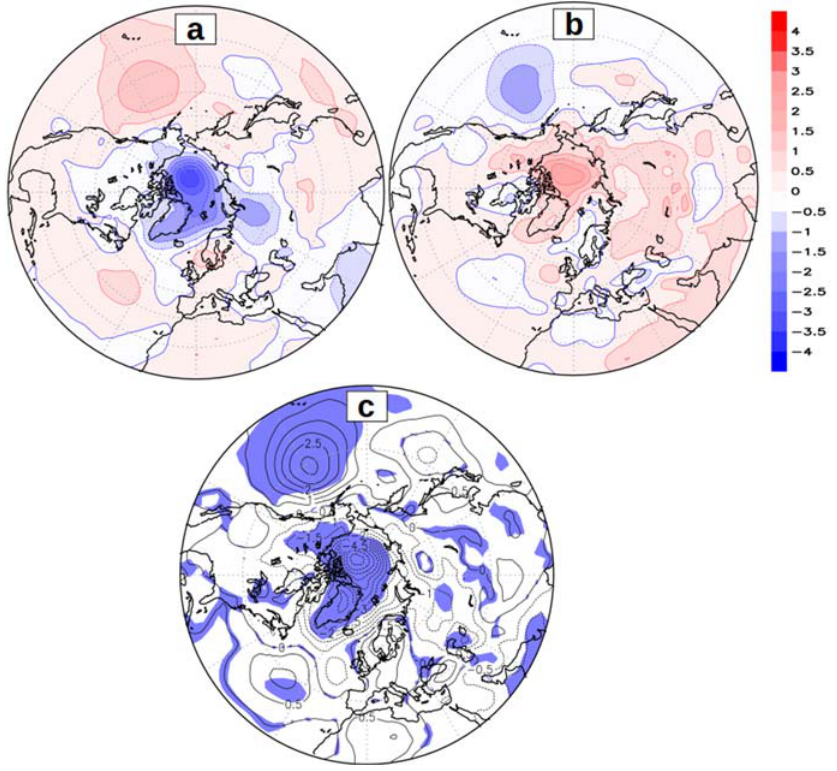
Figure 5. Composites of JJAS (June–September) sea ‐ level pressure (hPa) anomaly ( a ) strong ISM years, ( b ) weak ISM years, and ( c ) the difference between ( a , b ) with statistically significant regions shaded at a 90% significance level.